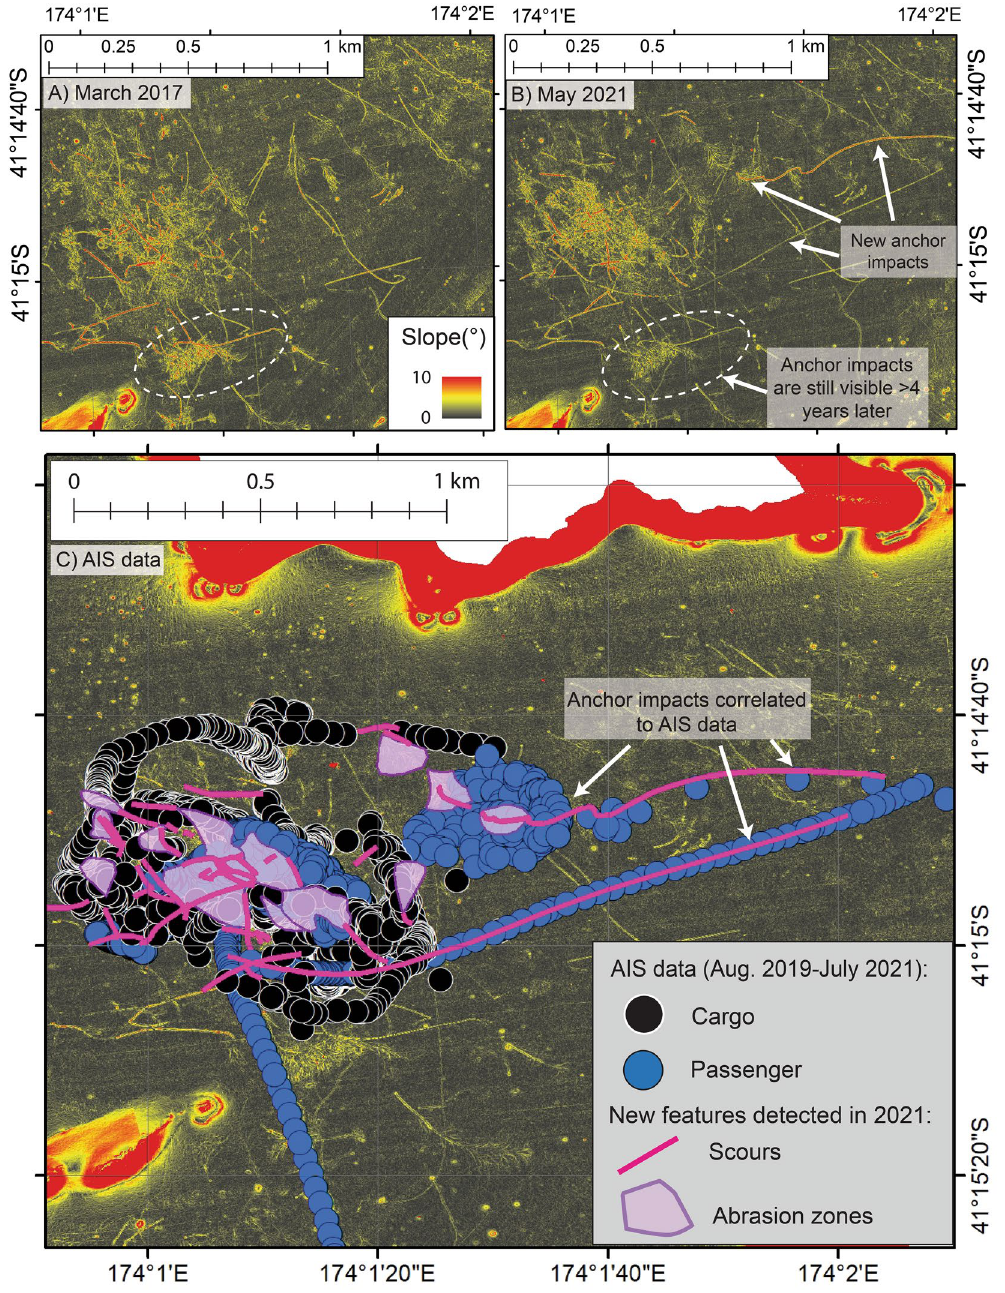
Figure 3. Seafloor slope showing a snapshot of the anchor footprint in Picton in 2017 ( A ) and in 2021 ( B ). The 2021 survey reveals new scours and abrasion zones that have occurred since the 2017 survey. White dashed circle shows the same anchor marks are visible in both datasets suggesting that the physical footprint of anchoring persists on the seabed for at least 4 years in mud-dominated substrate, although with more subdued appearance. ( C ) Seafloor slope with new scours (pink lines) and abrasion zones (purple polygons) that were digitised in 2021 survey. AIS ship tracking data over 2-years (August 2019-2021) shows that high-tonnage cargo (black points) and passenger (blue points) vessels use the Picton anchorage during this time. In some cases, AIS data can be directly correlated to individual anchor impacts on the seabed (example